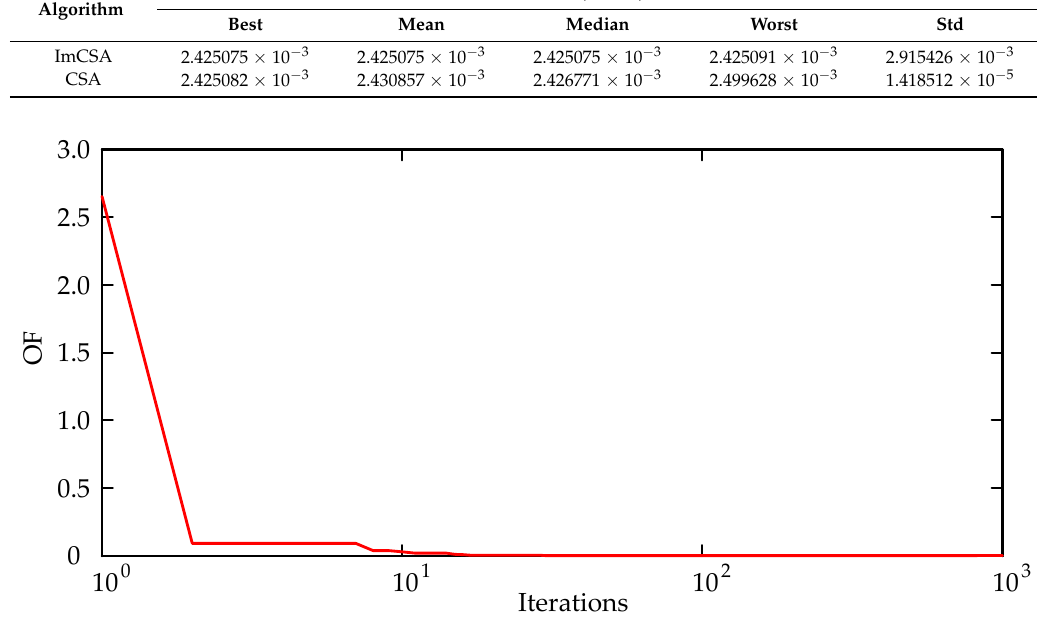
Figure 8. Convergence characteristic of the proposed ImCSA for parameter estimation of the PMM of Photowatt-PWP201 module.